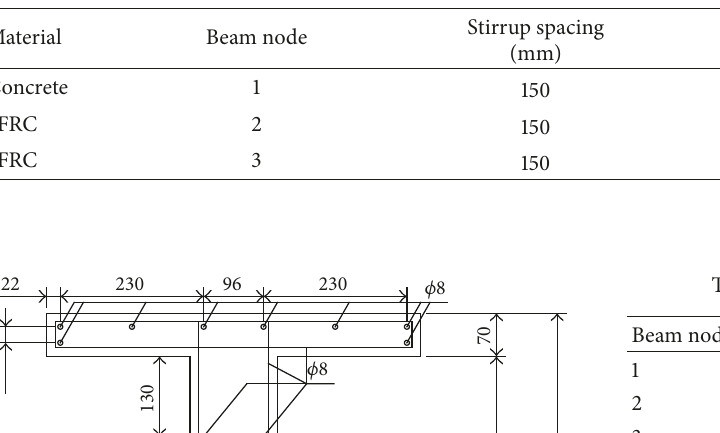
Table 1: Test T-beam parameters.